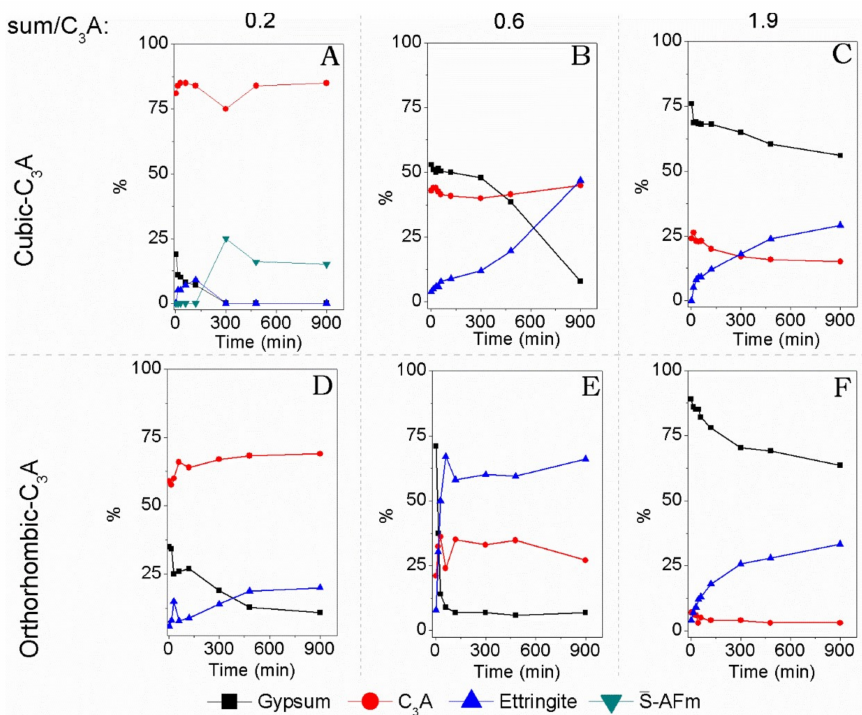
Figure 5. Reference intensity ratio (RIR) analysis of cub-C 3 A hydration with gypsum/C 3 A ratios of ( A ) 0.20; ( B ) 0.60; and ( C ) 1.9, and orth-C 3 A hydration with gypsum/C 3 A ratios of ( D ) 0.20; ( E ) 0.60; and ( F ) 1.9.